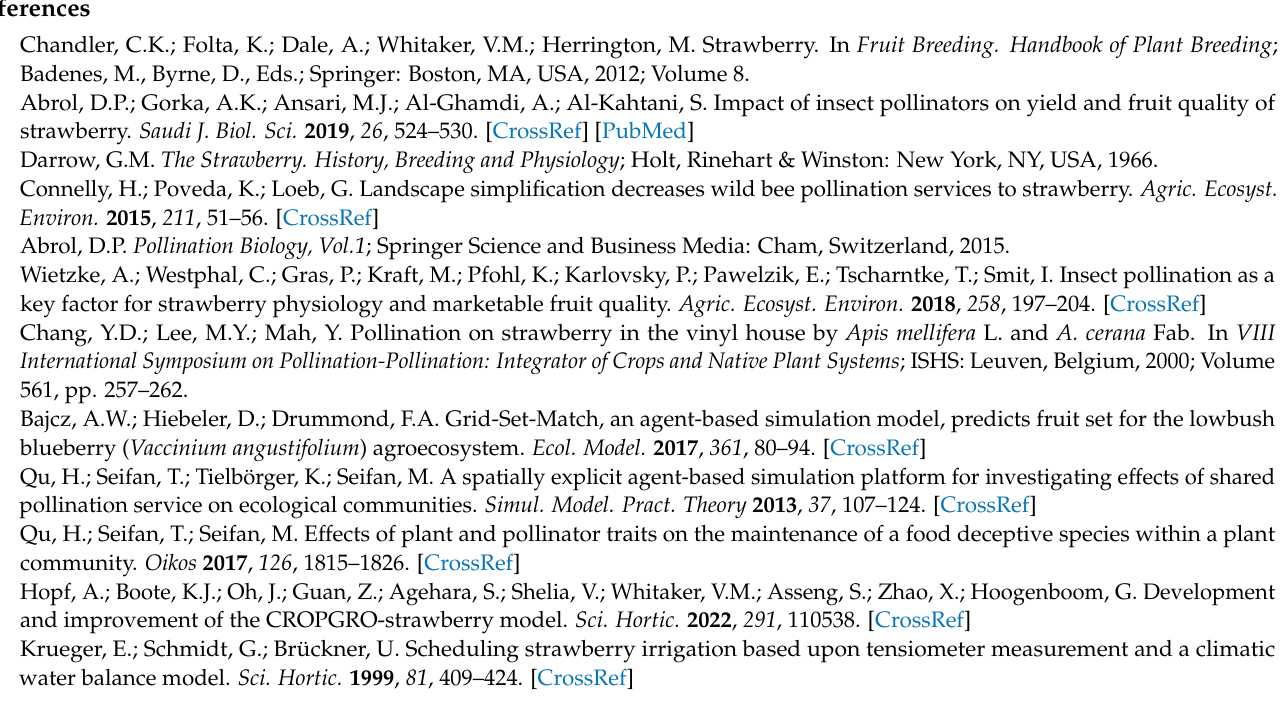
Table S2: Simulated strawberry fruit set, quality and yield with various bee densities (80 m long); Table S3: Simulated strawberry fruit set, quality and yield with various bee densities (60 m long); Figure S1: A simulated strawberry greenhouse; Figure S2: Timing schedule for the two harvests of strawberry simulation; Figure S3: Friendly graphical user interface of the simulation model in GAMA.; Figure S4: The relationship between bee abundance and fruit quality in greenhouse with a length of 60 m; Figure S5: Diagram to show the relationship between strawberry plant X-coordinate and fruit quality; Figure S6: Diagram to show the relationship between strawberry plant Y-coordinate and fruit